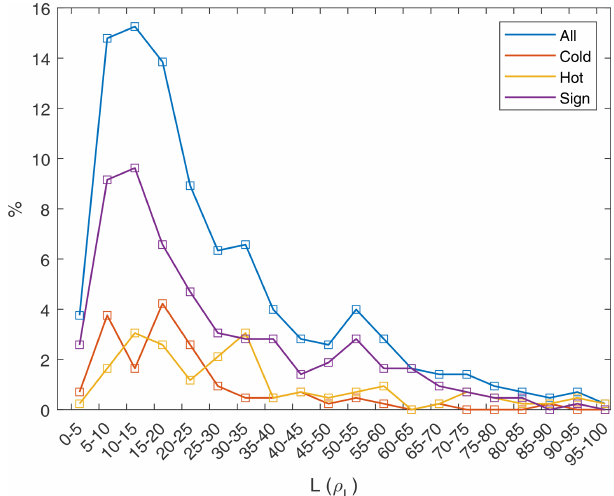
Figure 4. The distribution of the size L of the LMH structures in percentage of total events. The colour coding is the same as in Fig. 2.